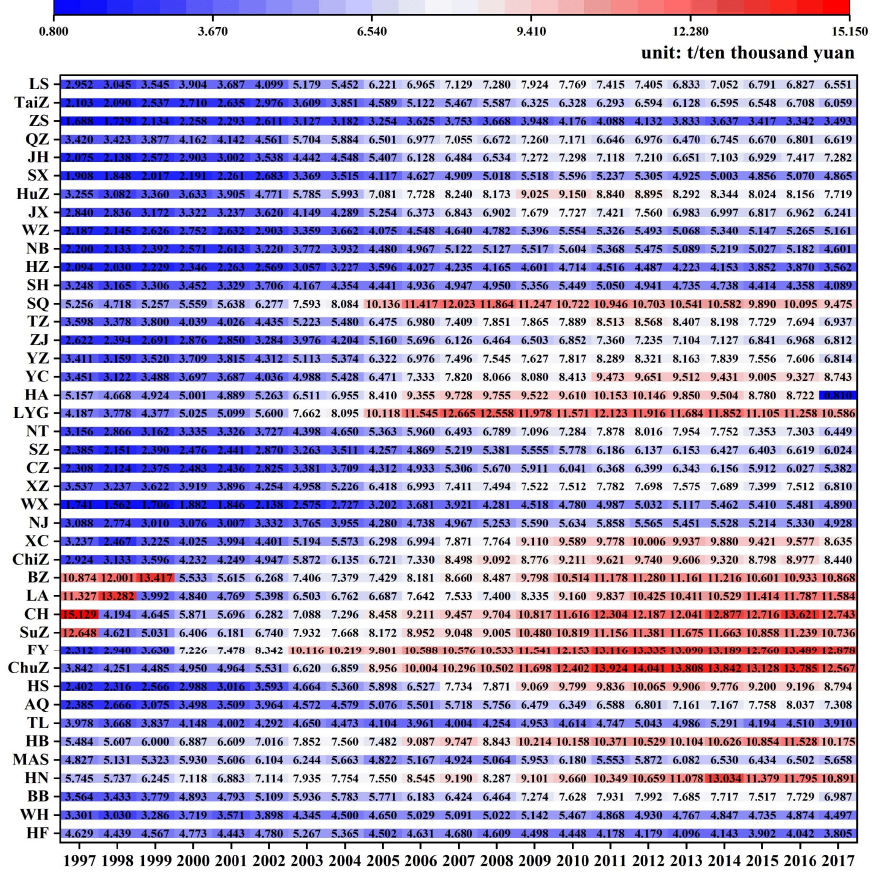
Figure 3. Temporal variation heat map of carbon emission intensity in cities of the Yangtze River Delta from 1997 to 2017.